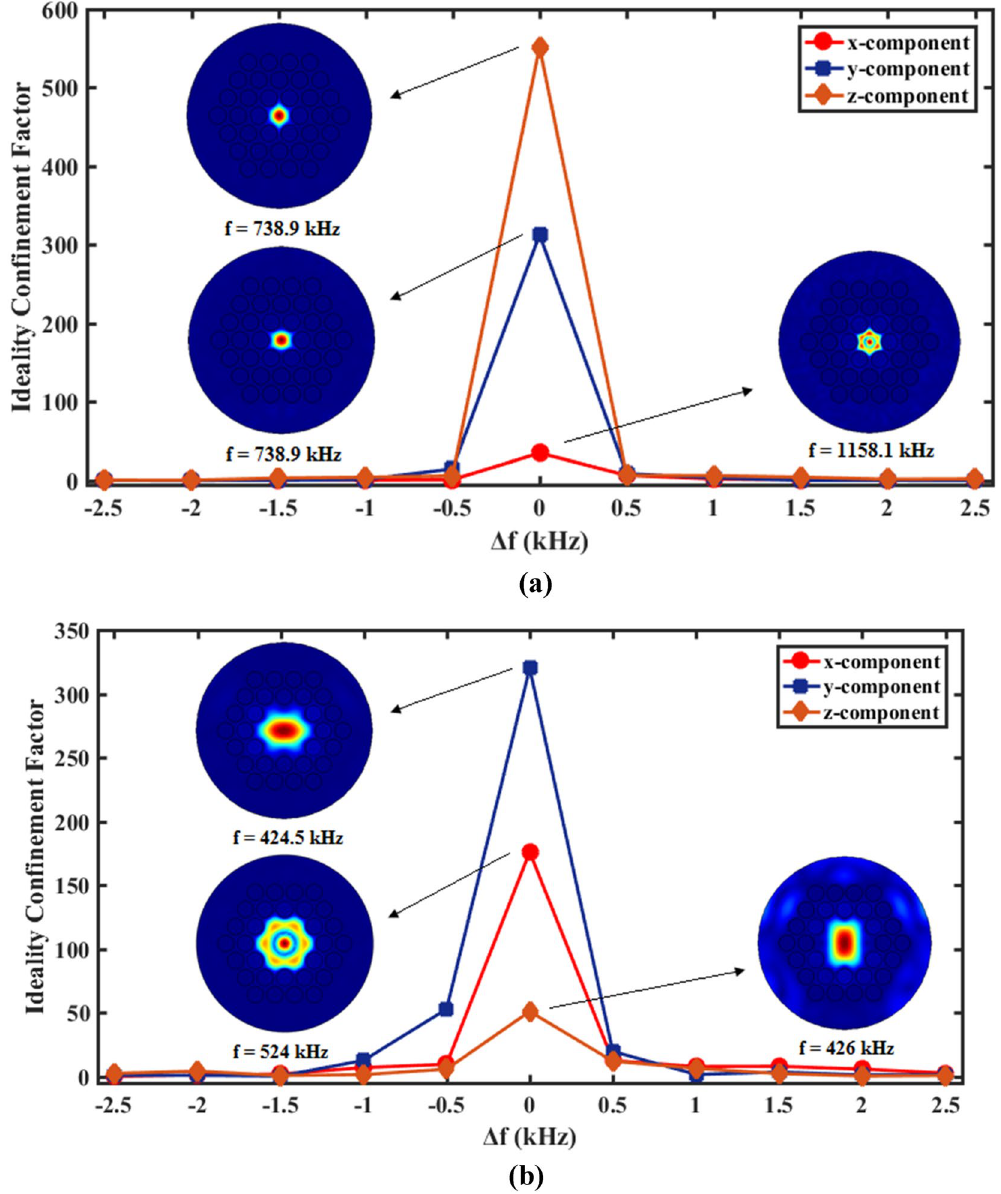
Figure 6. The confinement quality factor of designed phononic crystal fibers with ( a ) small and ( b ) large in the 2.5 kHz frequency range around the resonance